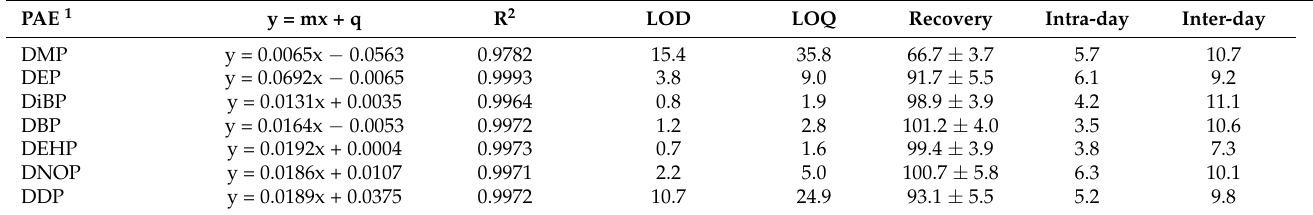
Table 6. Regression equation (expressed as y = mx + q) and related correlation coefficient, limit of detection (LOD, ng mL − 1 ) and limit of quantification (LOQ, ng mL − 1 ), recovery (% ± s.d.), and precision and reproducibility as inter-day and intra-day (% ± s.d.) errors for each PAE investigated in this study by UVA-DLLME–GC-IT/MS.